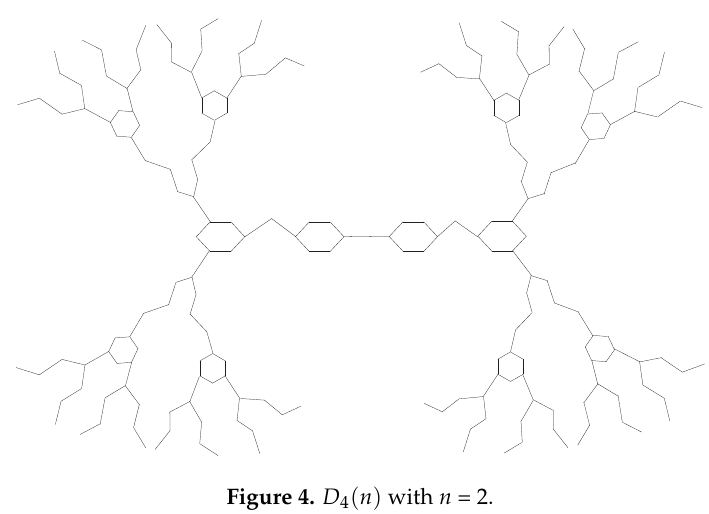
Figure 4. D 4 ( n ) with n =